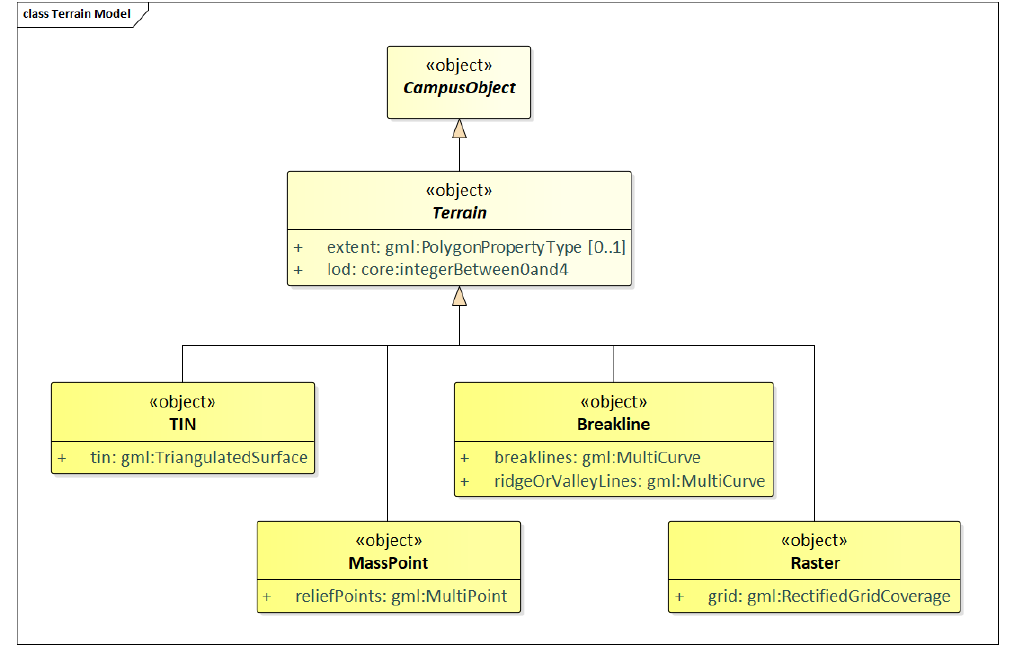
Figure 14. UML diagram of terrain